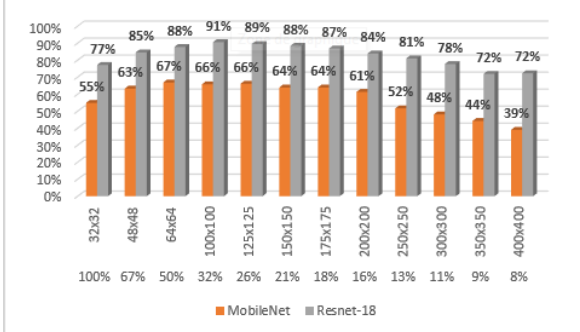
Figure 9. The Top-1 classification rate of test images from the CVL dataset for both Resnet-18 and MobileNet models with several sizes of the original patches